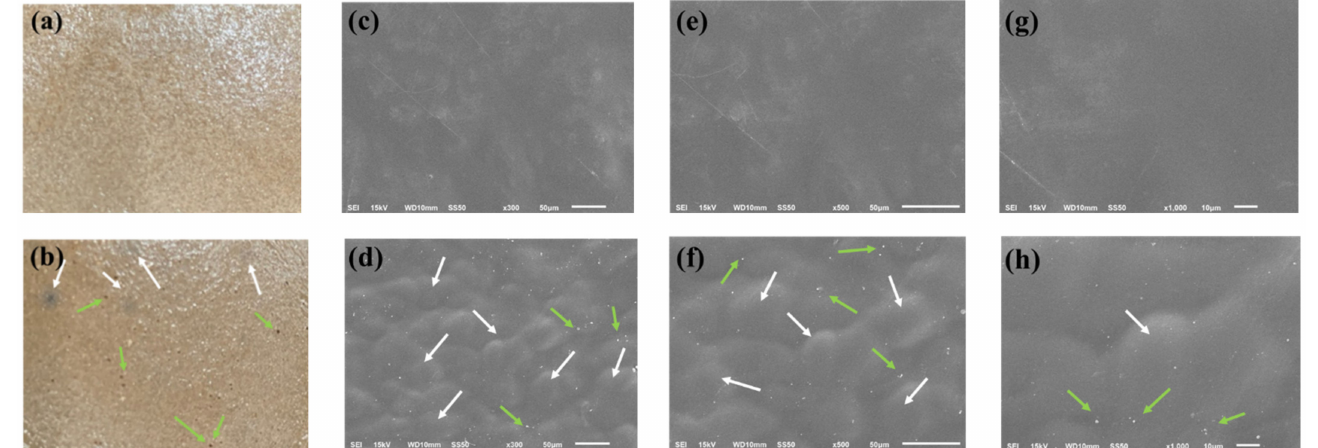
Figure 1. Images of biodegradable containers made from pork skin gelatin, walnut shells, and eggshells. ( a ) Surface of PEW1: pork gelatin, eggshell and 0.08 wt% walnut shell; ( b ) surface of PEW2: pork gelatin, eggshell and 0.14 wt% walnut shell; ( c , e , g ) representative SEM photographs of PEW1 surfaces at magnifications of 300, 500 and 1000 × , respectively; ( d , f , h ) representative SEM photographs of PEW2 surfaces at magnifications of 300, 500 and 1000 × ,